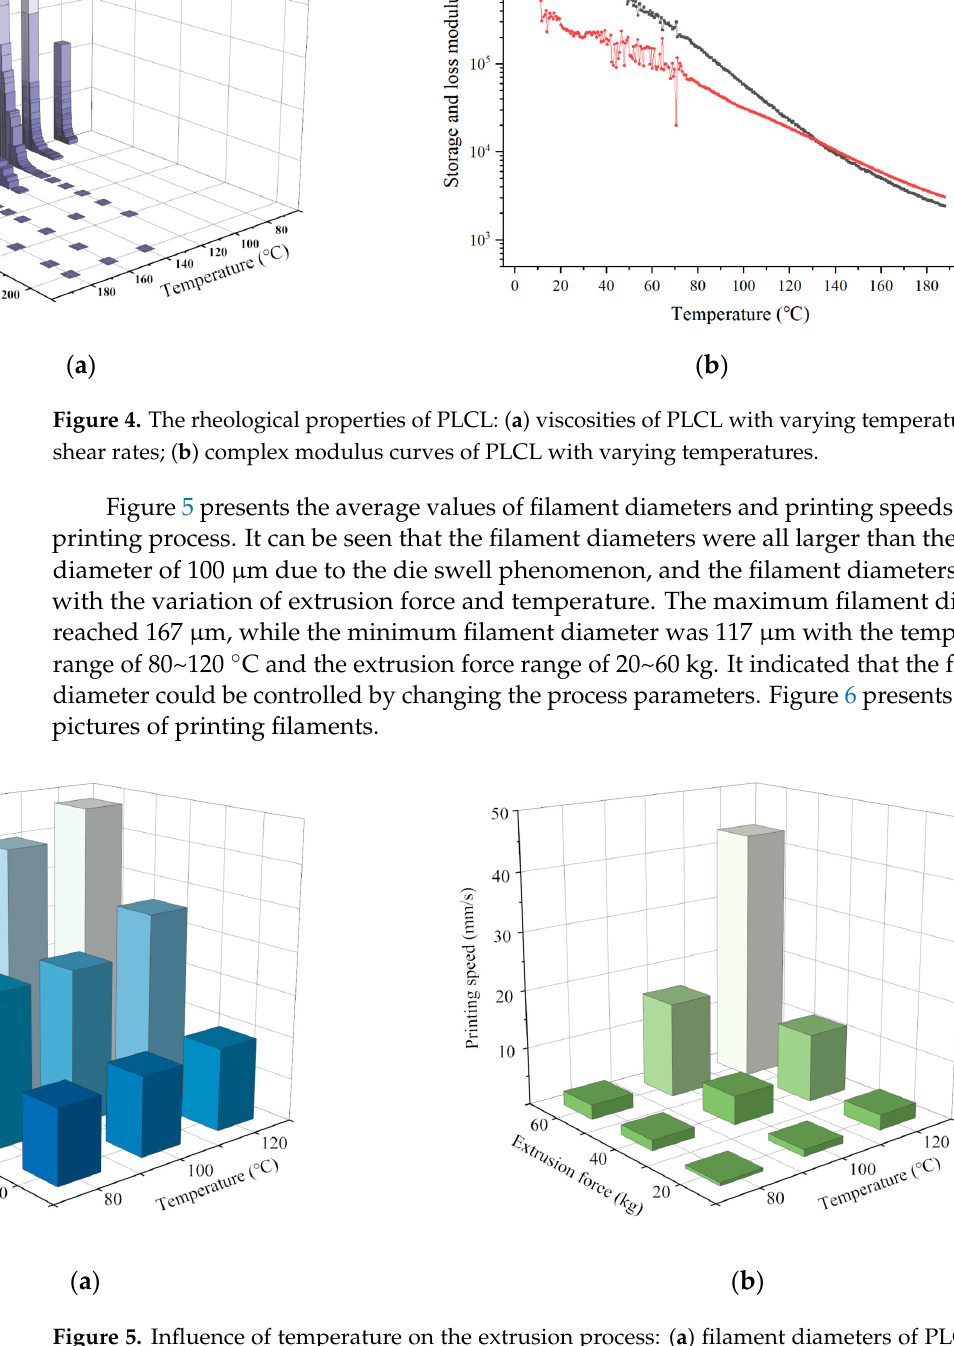
Figure 6. Images of the printing filaments at 100 °C. To explain the variation of filament diameters in Figure 5a, the printing speed must be taken into consideration. According to the theory of polymer conformation, during the extrusion 3D process of PLCL melts, the die swell phenomenon always occurs and is re- lated to the entropic elasticity [24]. Conformational entropy is a kind of entropy which is related to the number of conformations of a molecule. Before the PLCL melts flow into the pipeline of the nozzle, the polymer conformation of each PLCL molecule is a random coil. The number of conformations of each random coil is always at maximum value, which means the PLCL melts possess maximum conformational entropy before entering the pipeline. When the melt enters into the pipeline, the velocity gradient of the PLCL flow in the pipeline changes the orientation of molecular chains and, consequently, leads to a de- crease in the number of conformations of the molecules. Thus, the conformational entropy of the PLCL melts also decreases. Meanwhile, the physical entanglements resulting from